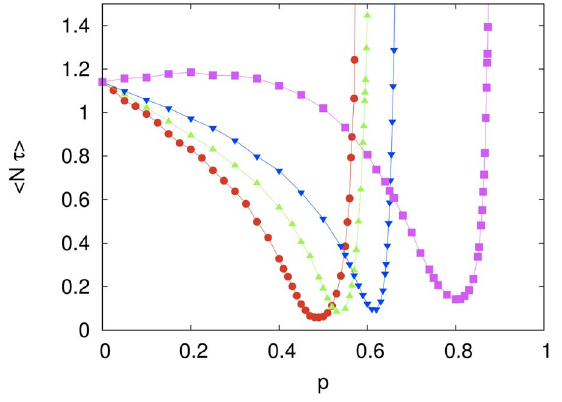
Figure 6. The effect of the imitation probability on the computational cost of partially connected systems. The symbols represent the mean rescaled computational cost S N t T for a system composed of N ~ 20 agents, each one connected to M ~ 19 (red circles), M ~ 9 (green triangles), M ~ 4 (blue inverted triangles) and M ~ 1 (magenta squares) influencers. The independent variable p is the imitation probability. Each symbol represents an average over 10 5 searches and the lines are guides to the eye. The error bars are smaller than the size of the symbols.